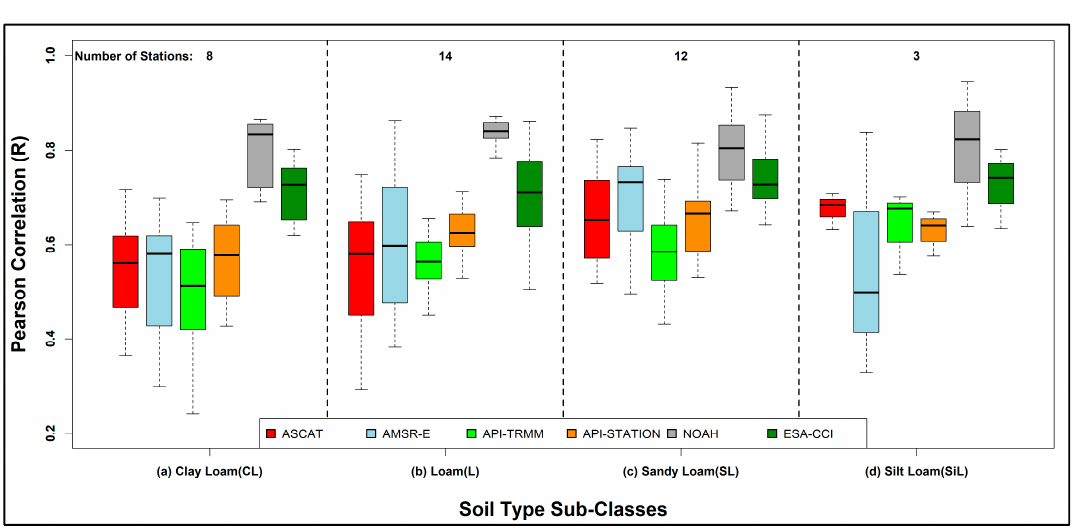
Figure 11. RMSE of soil moisture products under climate sub-classes.